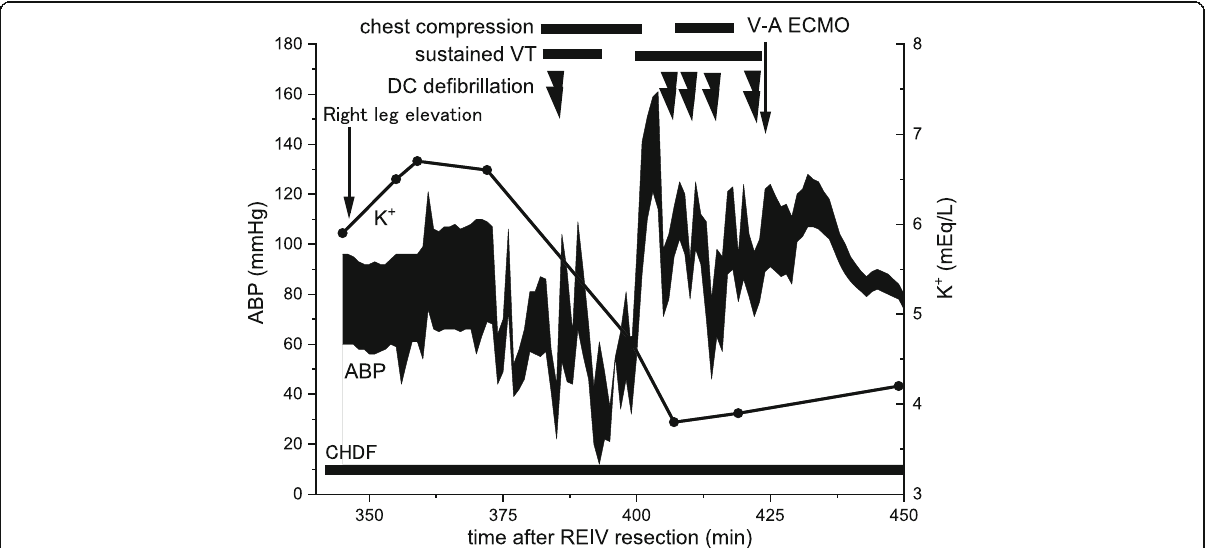
Fig. 1 Time course in the intensive care unit after right external iliac vein resection. Blood potassium level was rapidly elevated after elevating the